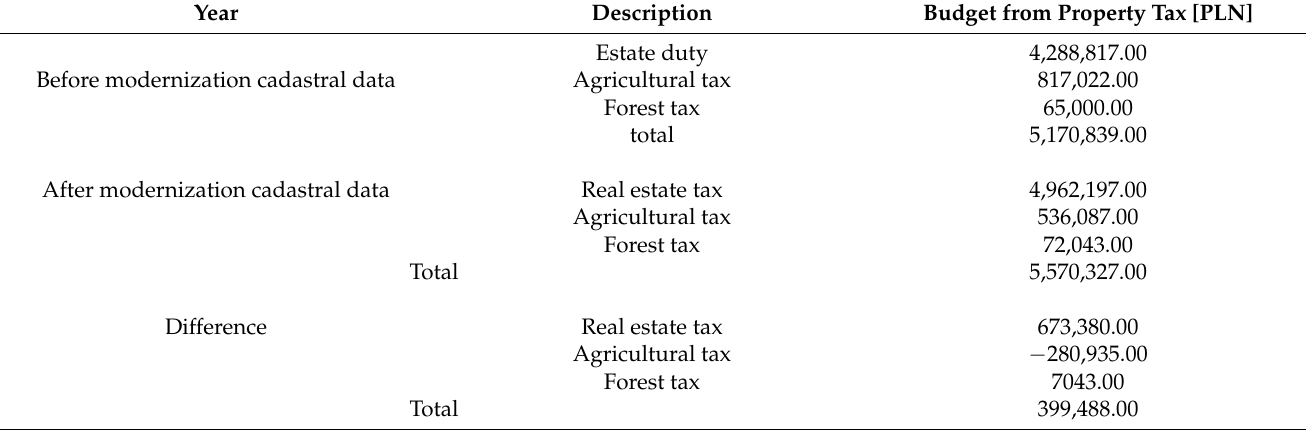
Table 3. Comparison of the real estate tax revenue before and after cadastral data